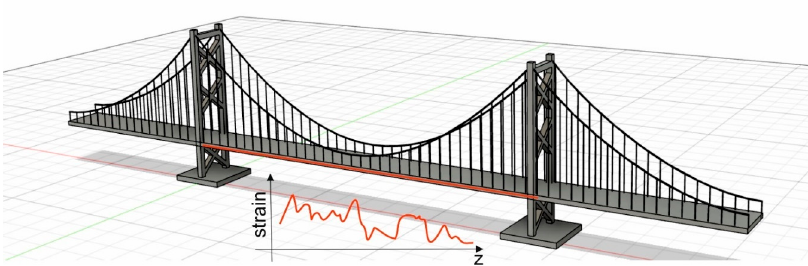
Figure 3. Distributed optical fiber sensors for structural health monitoring.